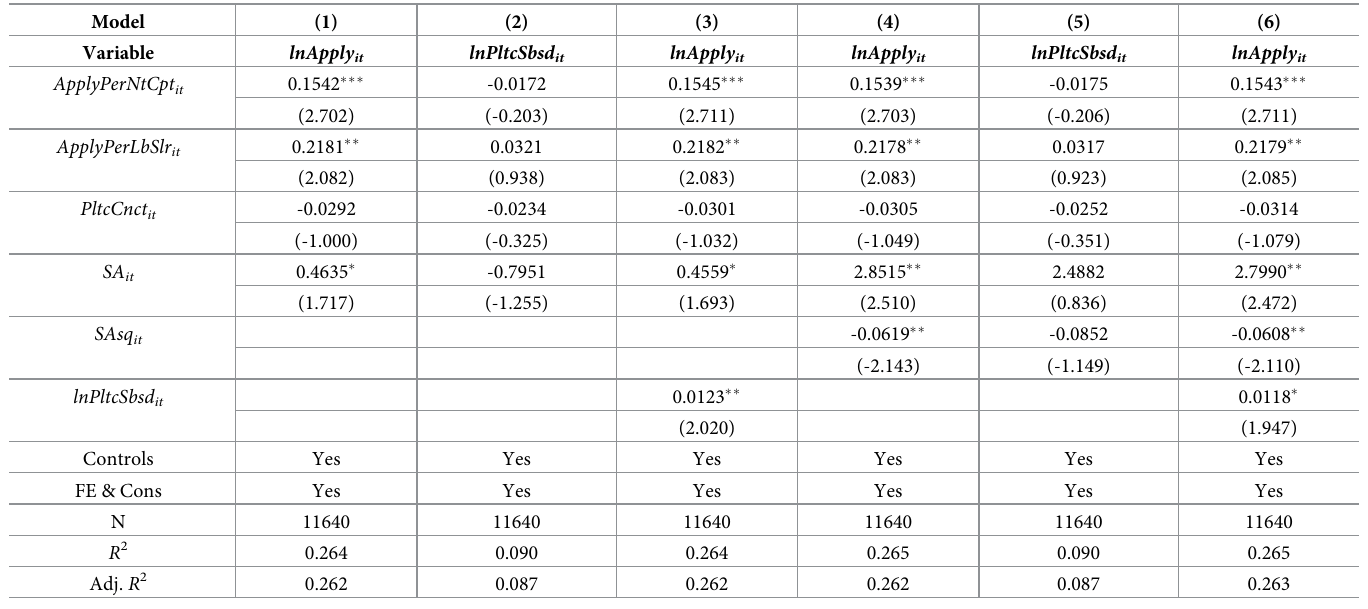
Table 8. Main results of time-invariant fixed